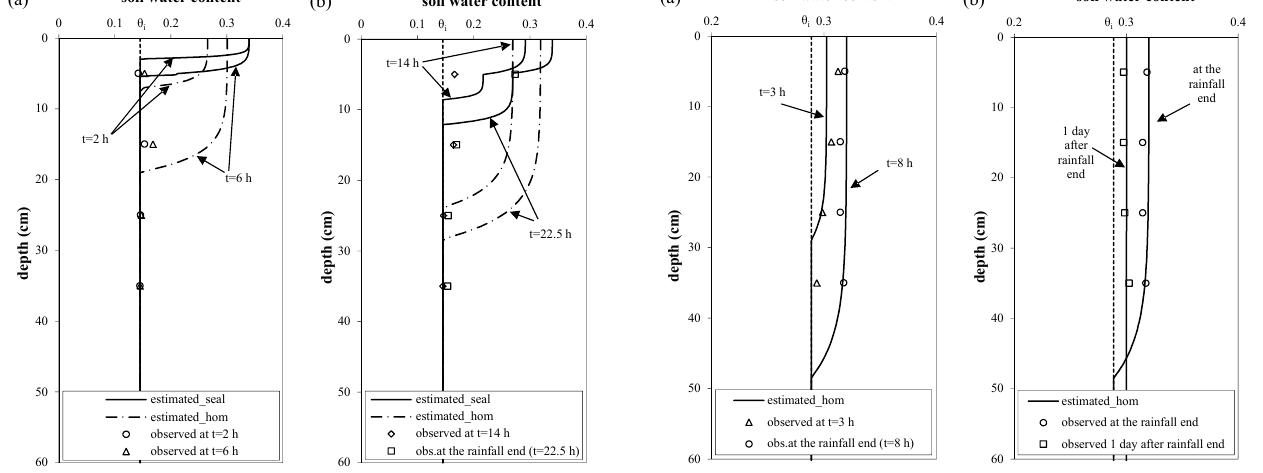
Fig. 5. Water content profiles simulated by the adopted models for homogeneous soil and sealed soil and specific values observed at different depths during different stages. Event 3 of Fig. 2 (see also Table 2). Saturated hydraulic conductivity of the parent soil 2mmh − 1 and seal layer 0.05mmh − 1 .